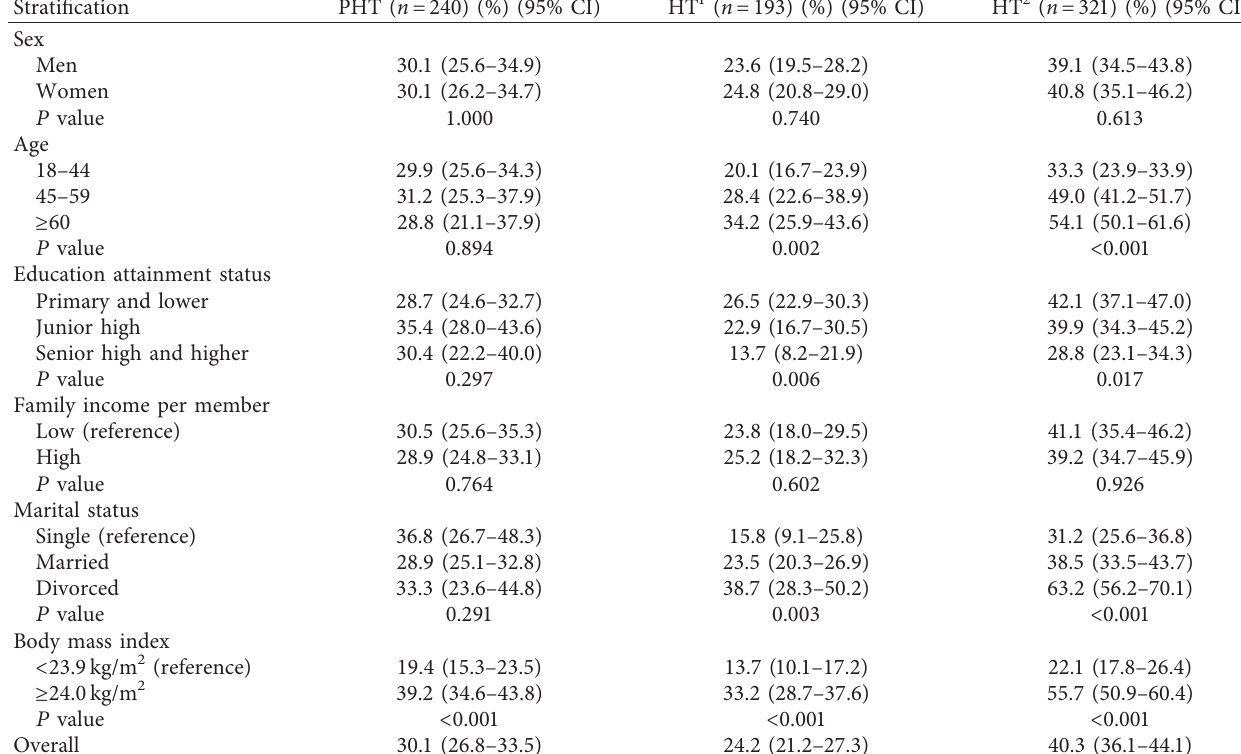
Table 2: Prevalence of prehypertension and hypertension in the study